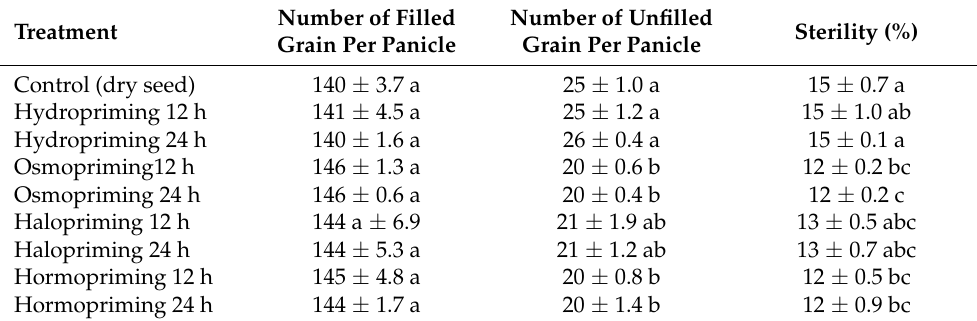
Table 10. Yield attributes (filled and unfilled grains per panicle and sterility %) of rice as affected by different seed priming in conventional DSR establishment method during 2018 at Ludhiana,